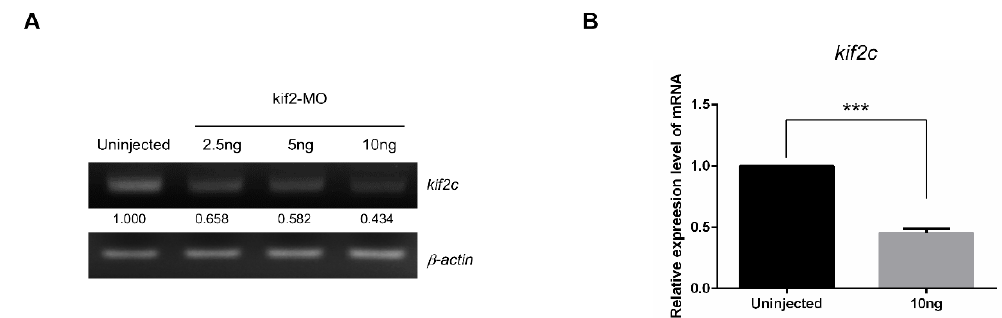
Figure 3. Expression of kif2c in zebrafish embryos is reduced by morpholino injection. ( A ) RT-PCR analysis of kif2c and β -actin using zebrafish embryos at 4 days post fertilization (dpf). Total RNA was isolated from uninjected embryos and kif2c -targeting morpholino-injected embryos (2.5 ng, 5 ng and 10 ng). Relative expression of kif2c is quantified using ImageJ. ( B ) Quantitative RT-PCR analysis of kif2c . Relative mRNA expression of kif2c is compared between uninjected control embryos and kif2c -targeting morpholino injected embryos. (*** indicates significance at p value < 0.001).